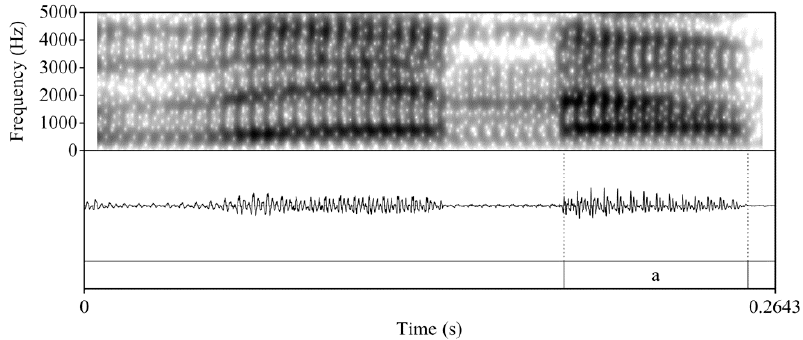
/ dena / ‘dena’ in Spanish